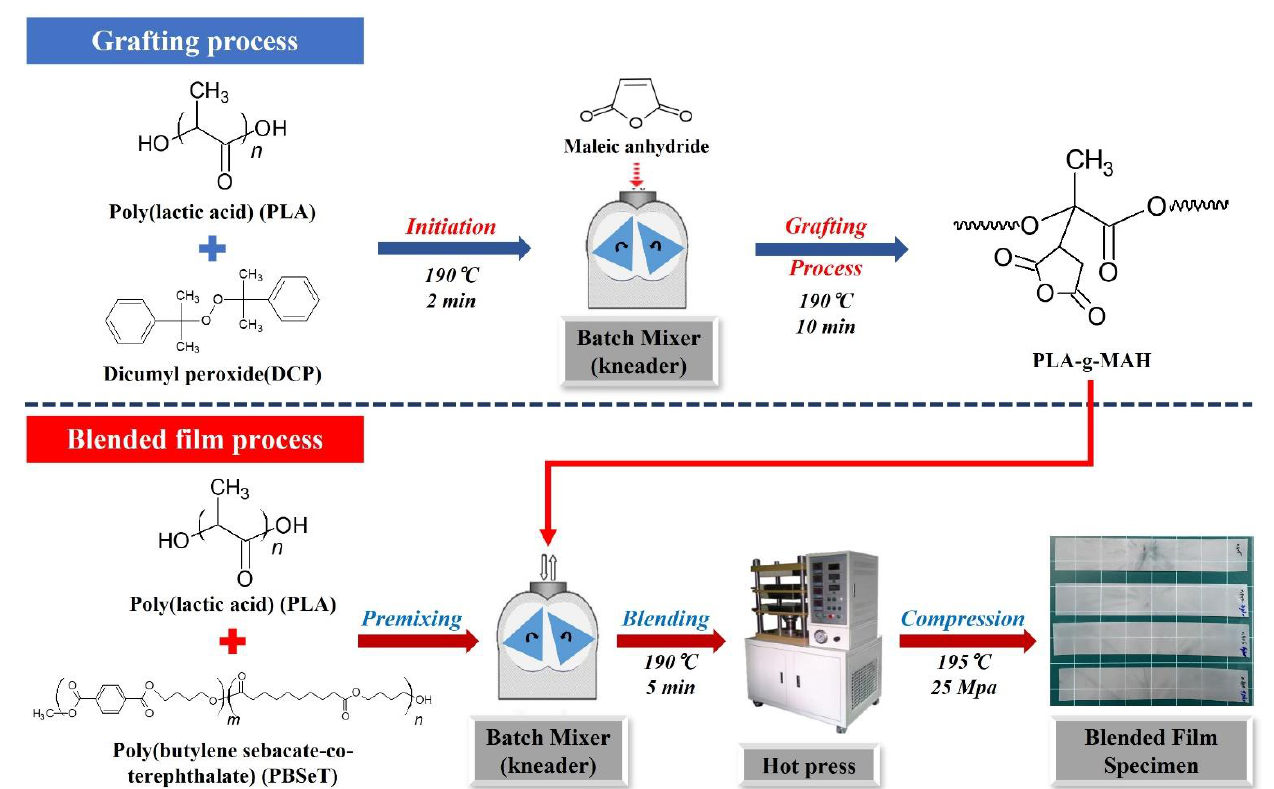
Figure 10. Experimental processes for ( top ) PLA grafting with DCP and MAH and ( bottom ) PLA/PBSeT/PLA-g-MAH blend formation.